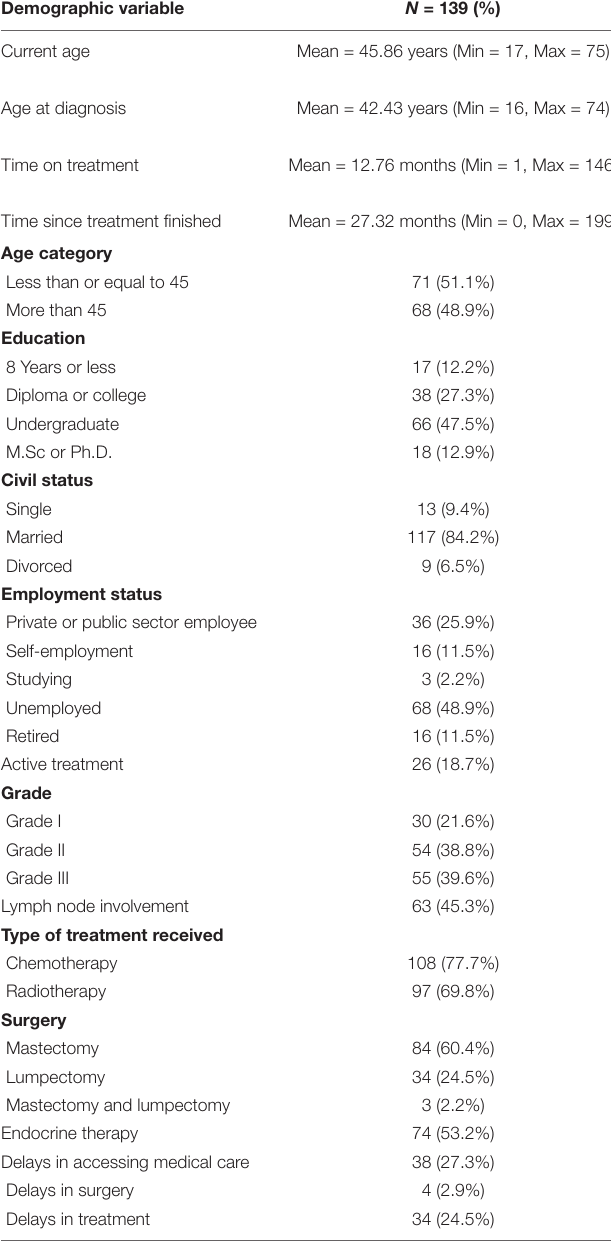
TABLE 1 | Participant demographics, clinical characteristics, and psychiatric